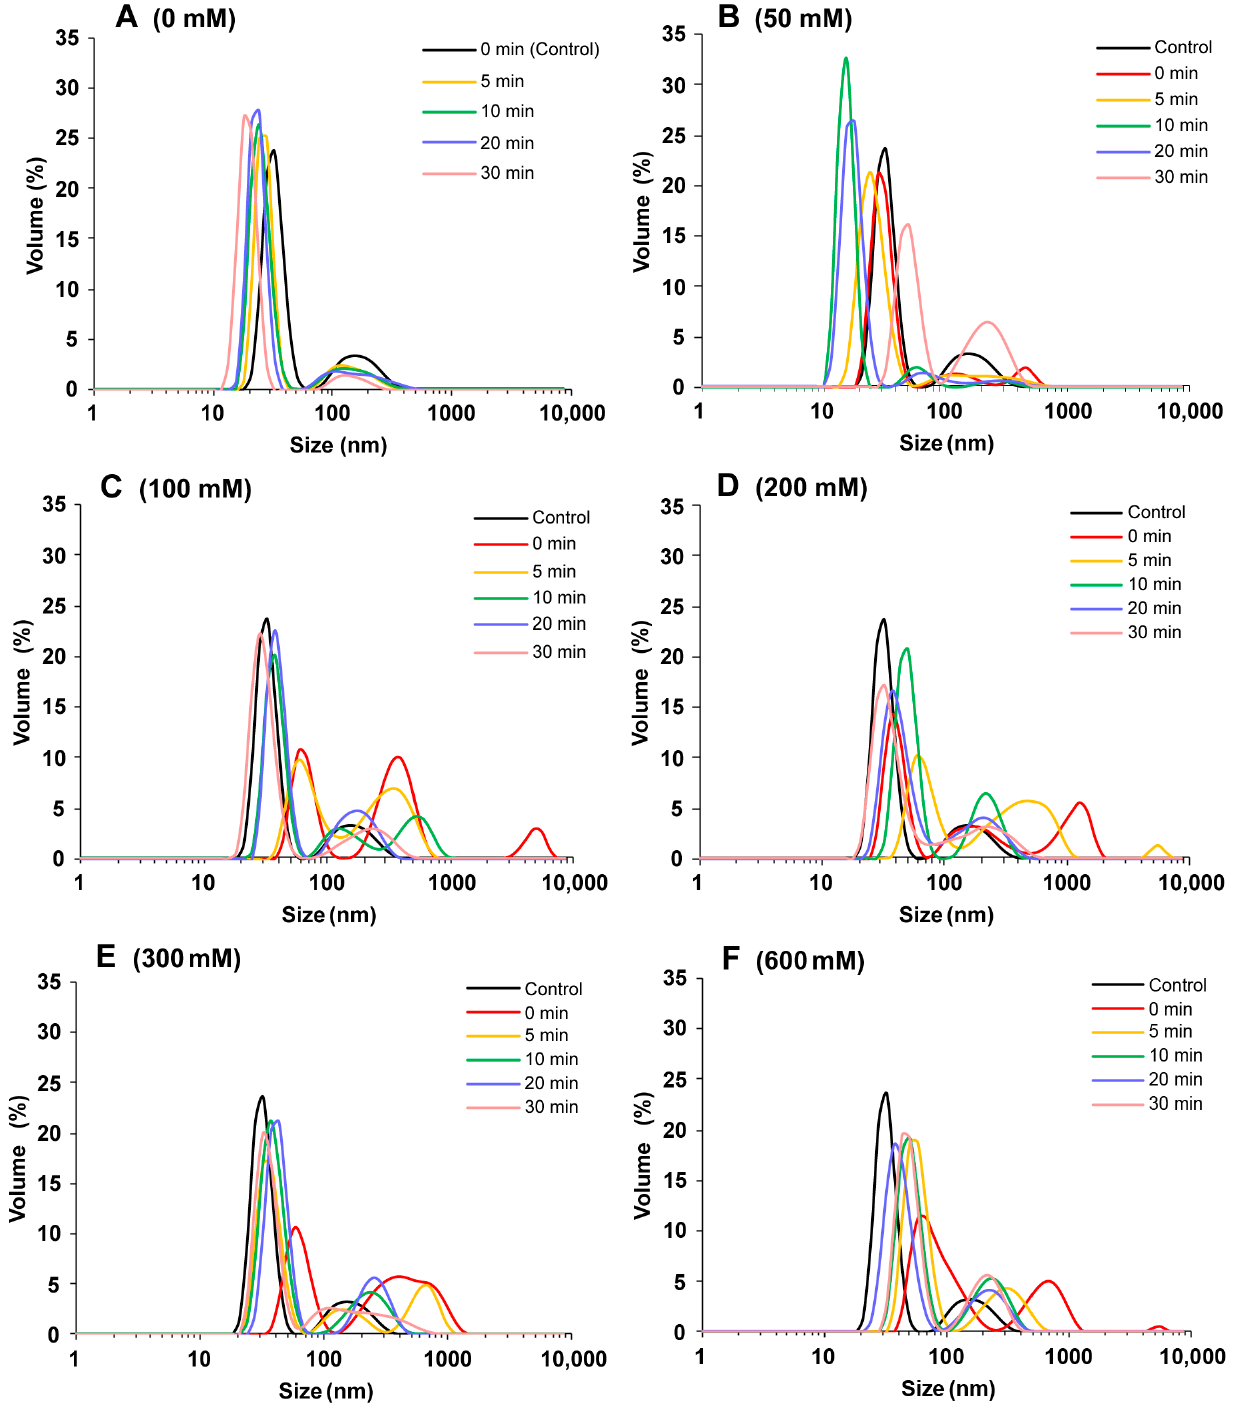
Figure 1. Particle size distribution of soy protein isolate treated with varying ultrasound processing time (0, 5, 10, 20, and 30 min) at different NaCl concentrations at 0 mM ( A ), 50 mM ( B ), 100 mM ( C ), 200 mM ( D ), 300 mM ( E ), and 600 mM ( F ).